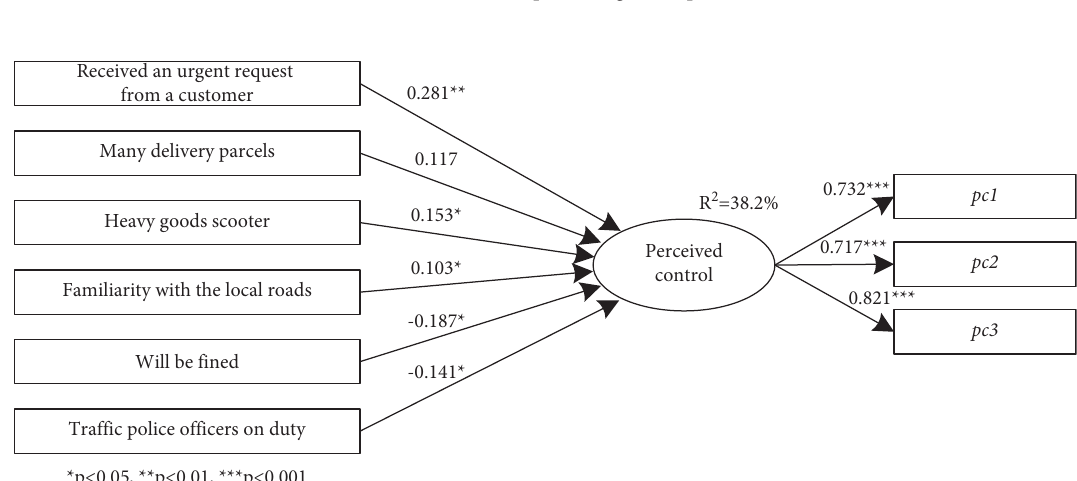
Figure 3: Norm referents predicting descriptive